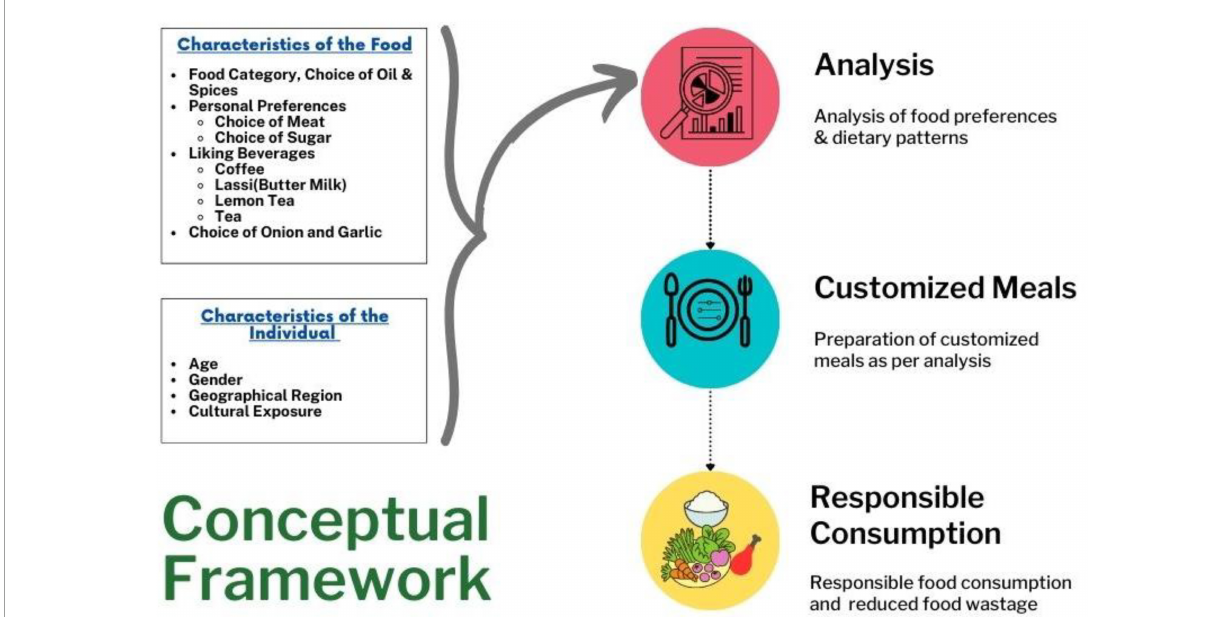
FIGURE3 Conceptual framework of customised food planning.